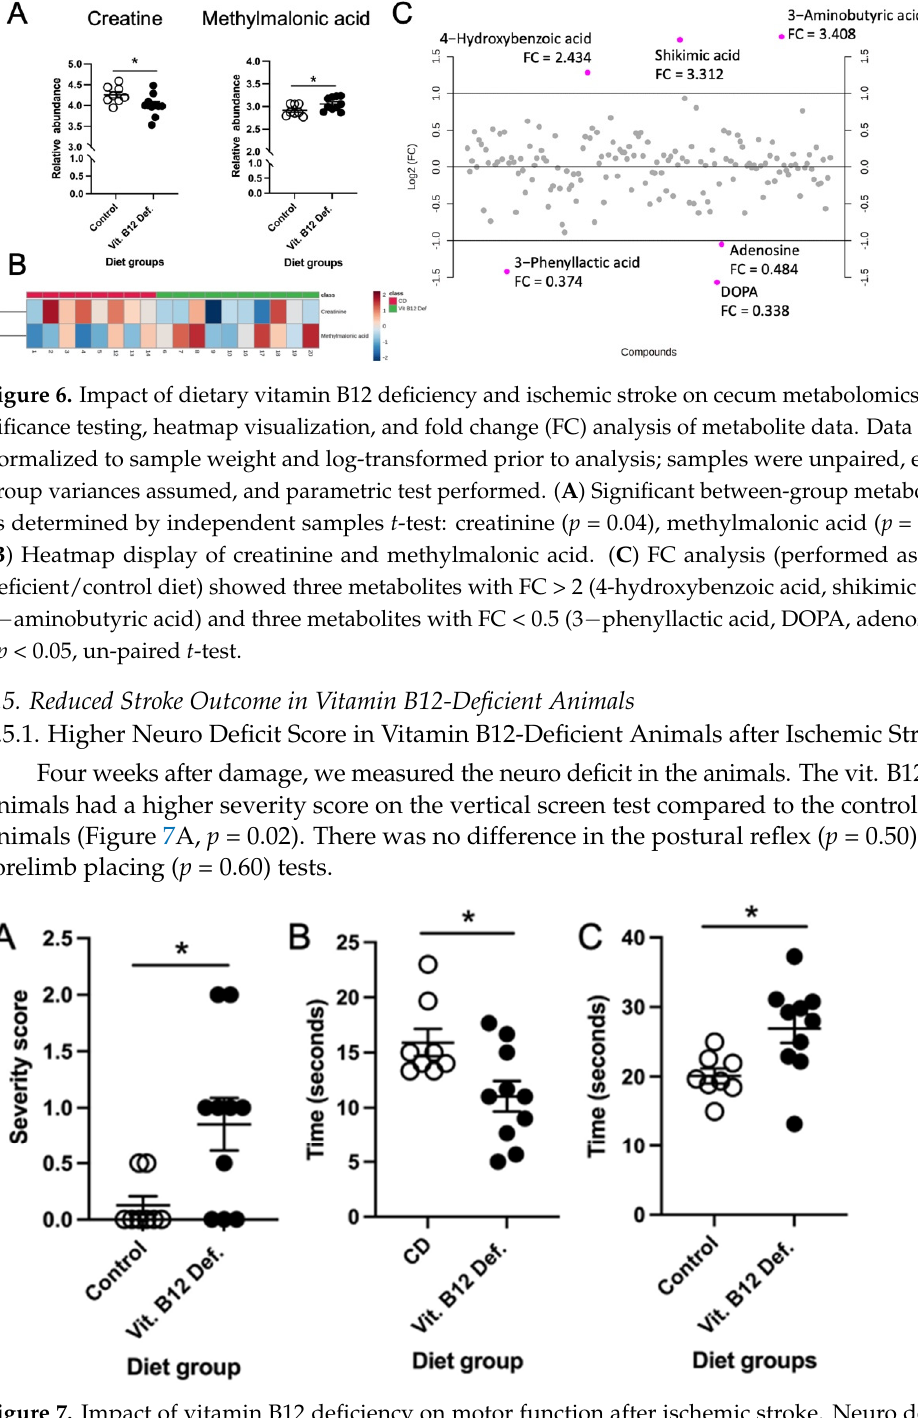
Figure 7. Impact of vitamin B12 deficiency on motor function after ischemic stroke. Neuro deficit score, vertical screen test severity score ( A ). Latency to fall off the accelerating rotarod ( B ). Amount of time to cross the ladder beam ( C ). Eight to ten mice per group. * p < 0.05, unpaired t -test.